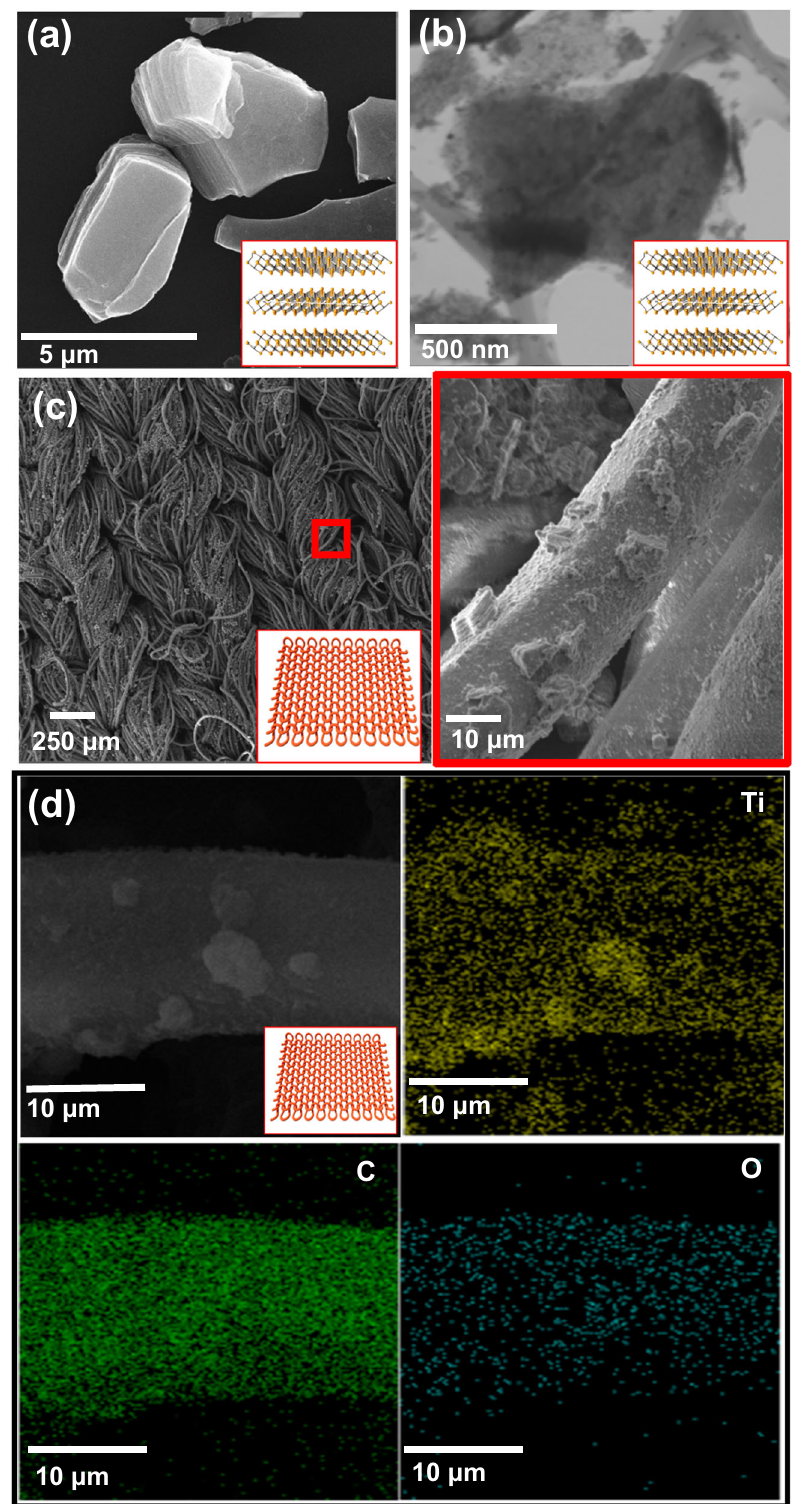
Fig. 3 Morphology study of Ti 3 C 2 and Ti 3 C 2 coated fabric. a , b SEM and TEM images of Ti 3 C 2 . c low- and high-magni fi cation SEM images of Ti 3 C 2 coated fabric. d EDS mapping of Ti 3 C 2 coated